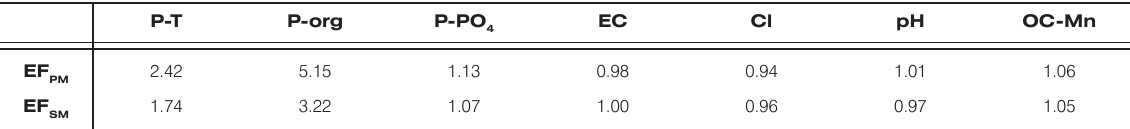
Table 4. Enrichment coefficient calculated for analyzes substances: selected forms of phosphorus, conductivity, chloride ions, pH, calcium and oxygen consumption